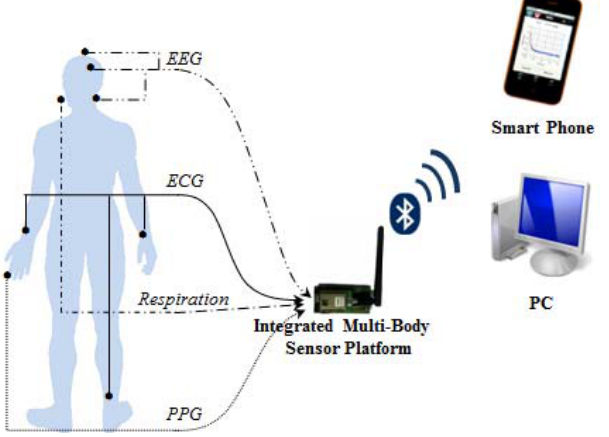
Figure 6. Environment for actual tests with integrated multi-body sensor platform.